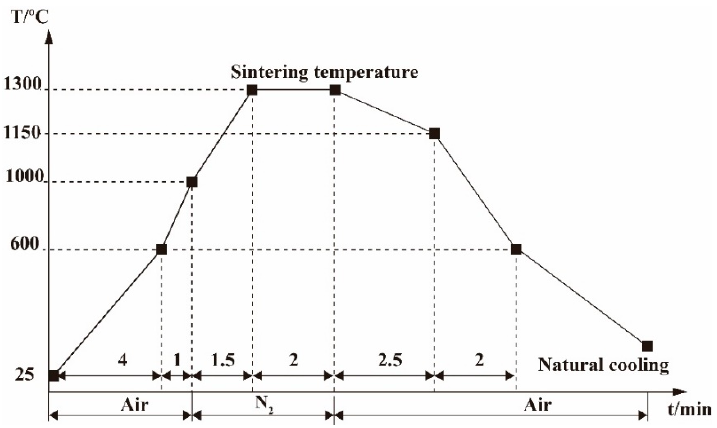
Figure 2. Temperature and atmosphere systems of micro-sintering test.